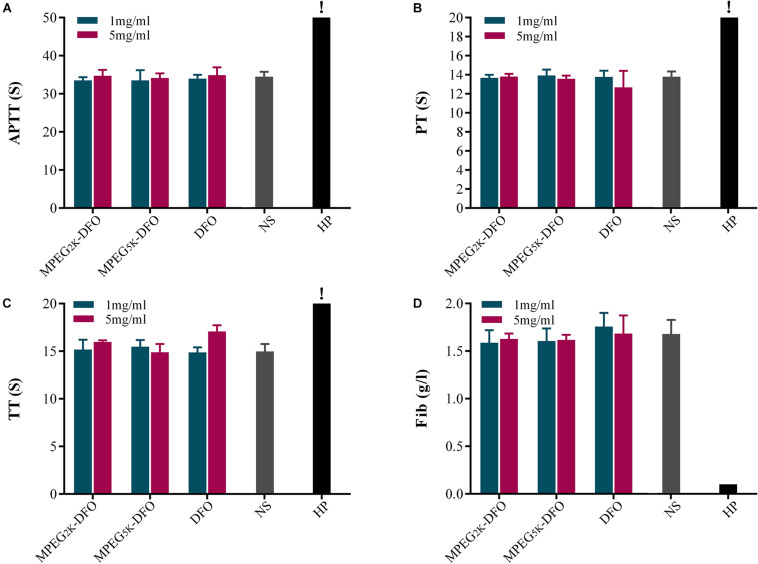
Effect of PEGylated DFO on the coagulation system. (A) APTT, (B) PT, (C) TT, and (D) Fib were tested by an automated coagulation analyzer. The values were too high to be measured (APTT > 245 s, TT > 169 s). HP, heparin. !: The values are too high that cannot be determined by the analyzer.